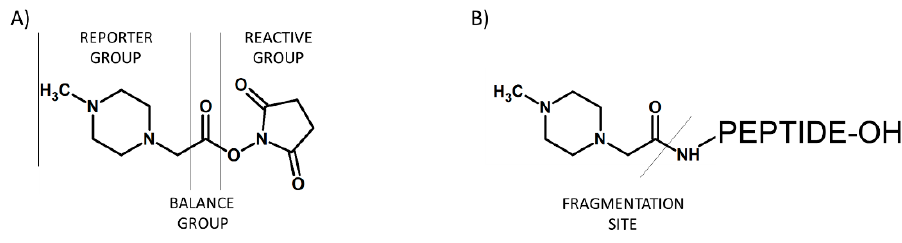
Figure 3. Schematic presentation of iTRAQ structure ( A ) and peptide labeled by iTRAQ ( B ).